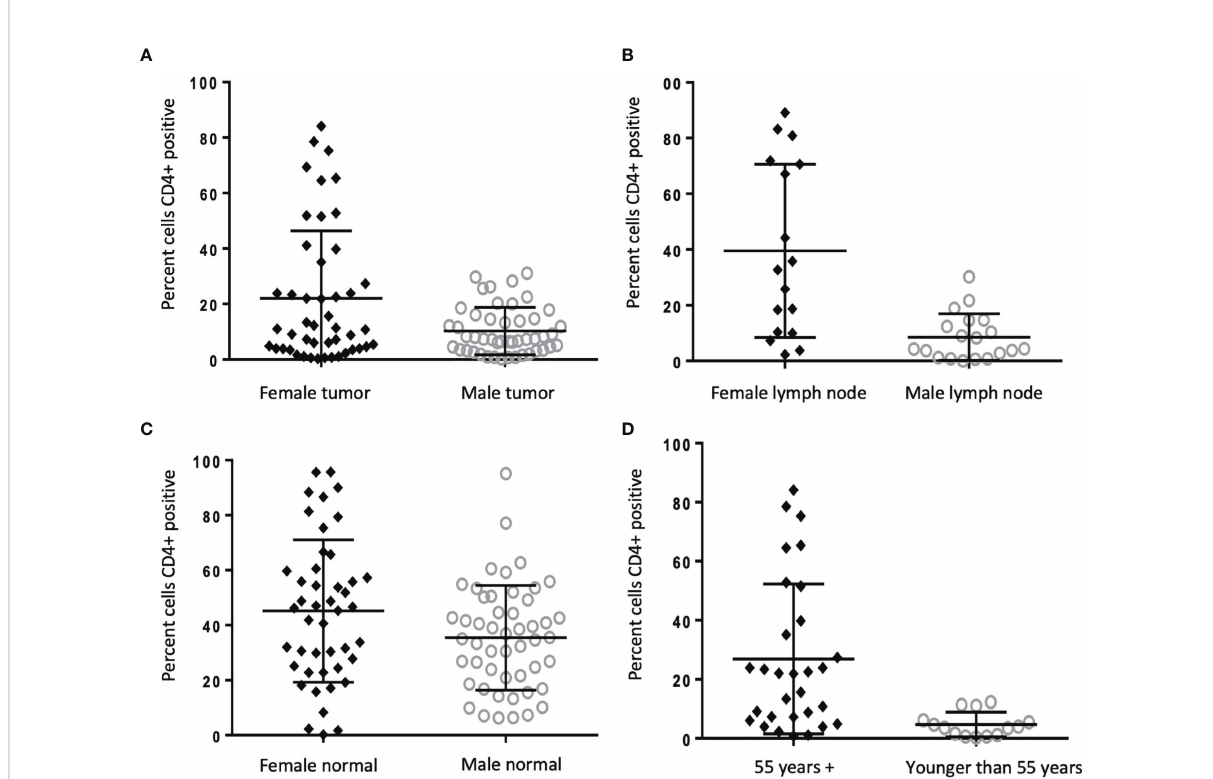
FIGURE 2 CD4+ cells increased in TME of women compared to men, and in older women compared to younger. (A-C) Frequency of CD4+ staining reported as percent cells positive in tumor (22.04% vs 10.26%, p=0.002), lymph node (39.54% vs 8.56%, p=0.001), and uninvolved colon tissue (3.9% vs 2.7%, p=0.045) from men (n = 50) and women (n = 51) with colon cancer. (D) Frequency of CD4+ staining reported as percent positive cells in tumor in women ages >55 (n = 30) compared to younger than 55 (n = 14) (26.9% vs. 4.7%,